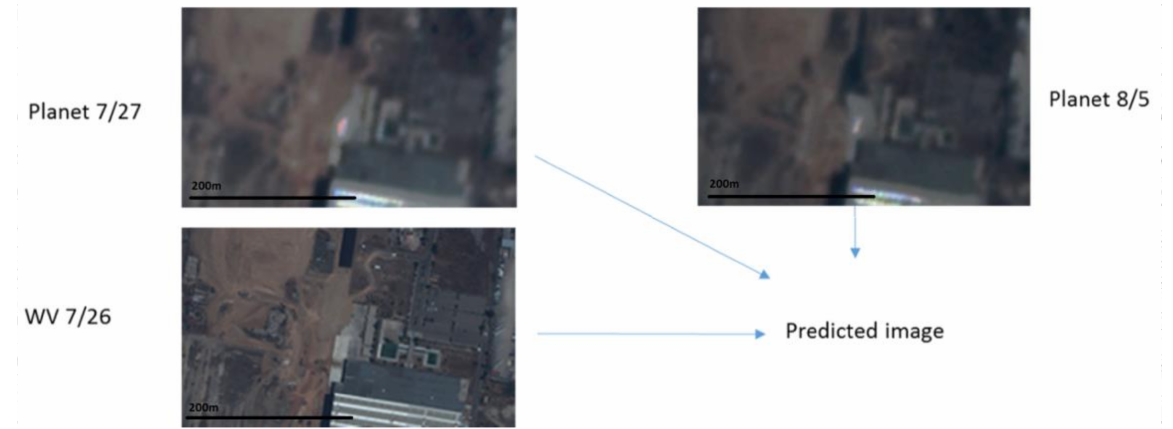
Figure 5. Two Planets images at 27 July and 5 August and one WV image at 26 July are fused to generate a prediction. The prediction is then compared to a WV image collected on 3 August 2017.